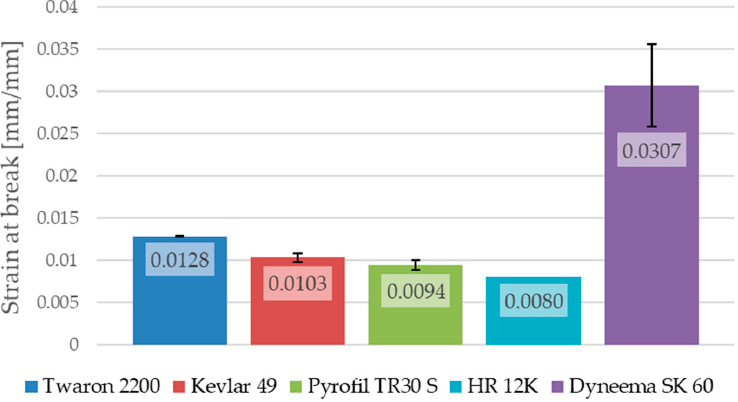
Figure 14. Average strain at break of the epoxy composites with various reinforcing materials.